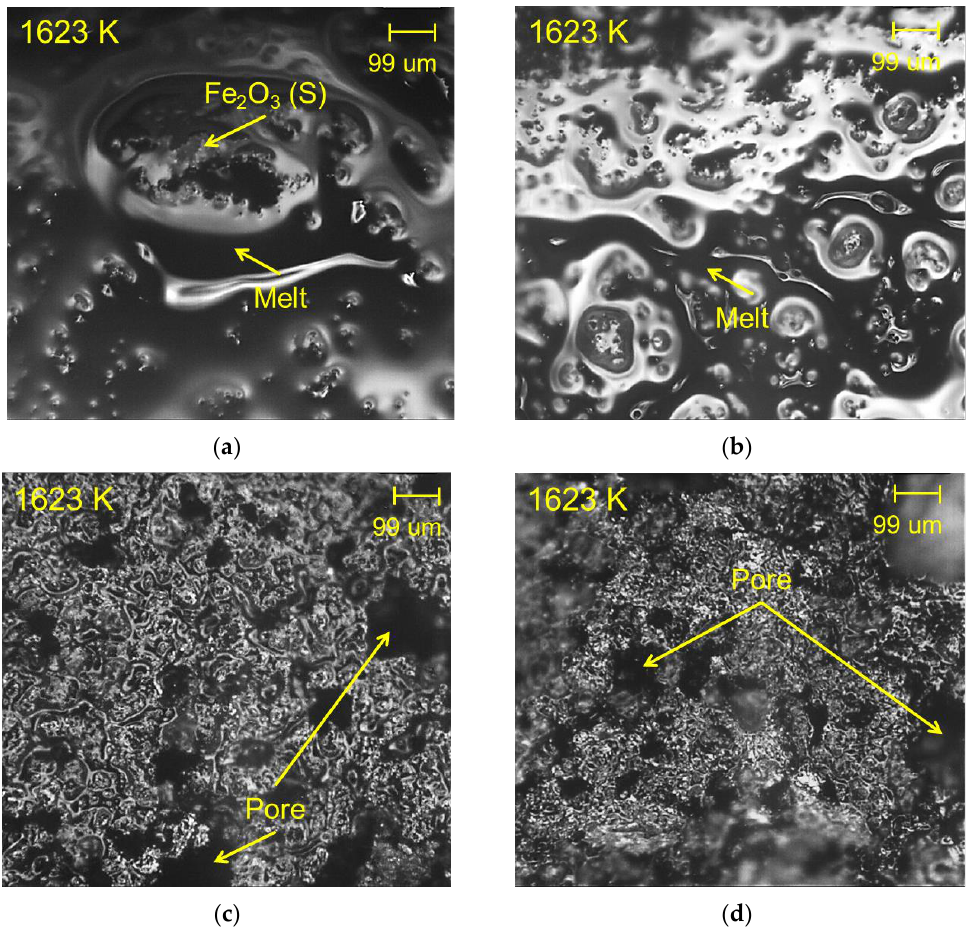
Figure 7. In situ observation of metastable sample morphology at 1623 K by CLM: ( a ) 0 mass% Al 2 O 3 , ( b ) 2.5 mass% Al 2 O 3 , ( c ) 5 mass% Al 2 O 3 , ( d ) 10 mass% Al 2 O 3 .